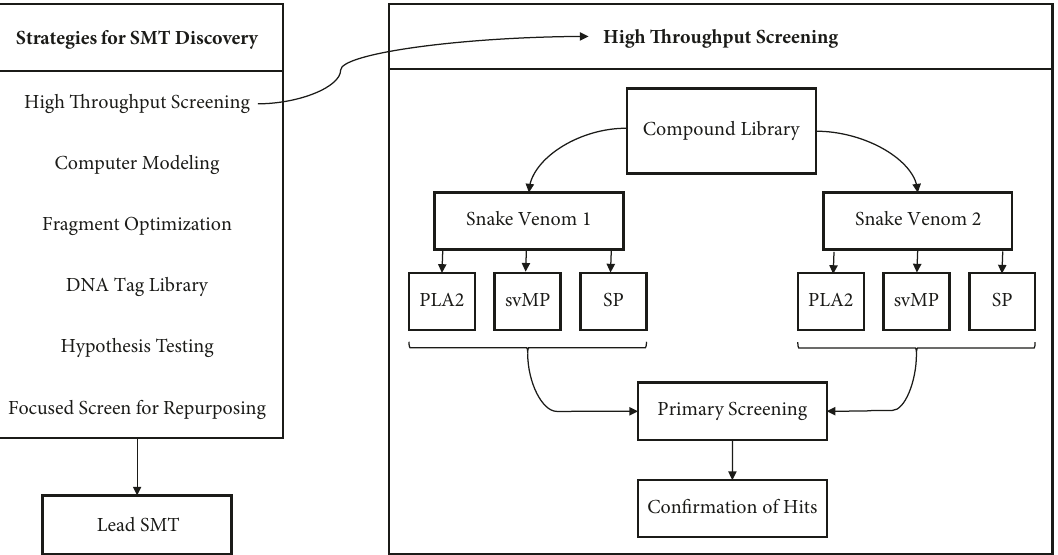
Figure 4: Hit to Lead: a variety of strategies to discover new SMTs and an example of processes and targets for High Throughput Screening (HTS) of candidate snake venom SMTs. sPLA 2 , svMP, and SP serve as examples of potential targets. Different assay methods are used for each type of enzymatic activity so screens would be run separately even if compound libraries were the same.